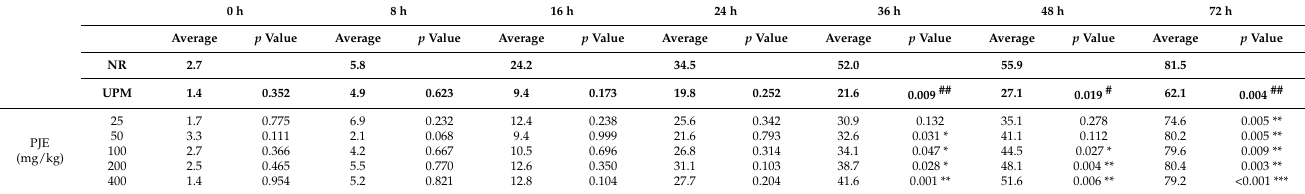
The mean and p values are presented. # p < 0.05, ## p < 0.01 compared to NR; * p < 0.05, ** p < 0.01, *** p < 0.001 compared to UPM.